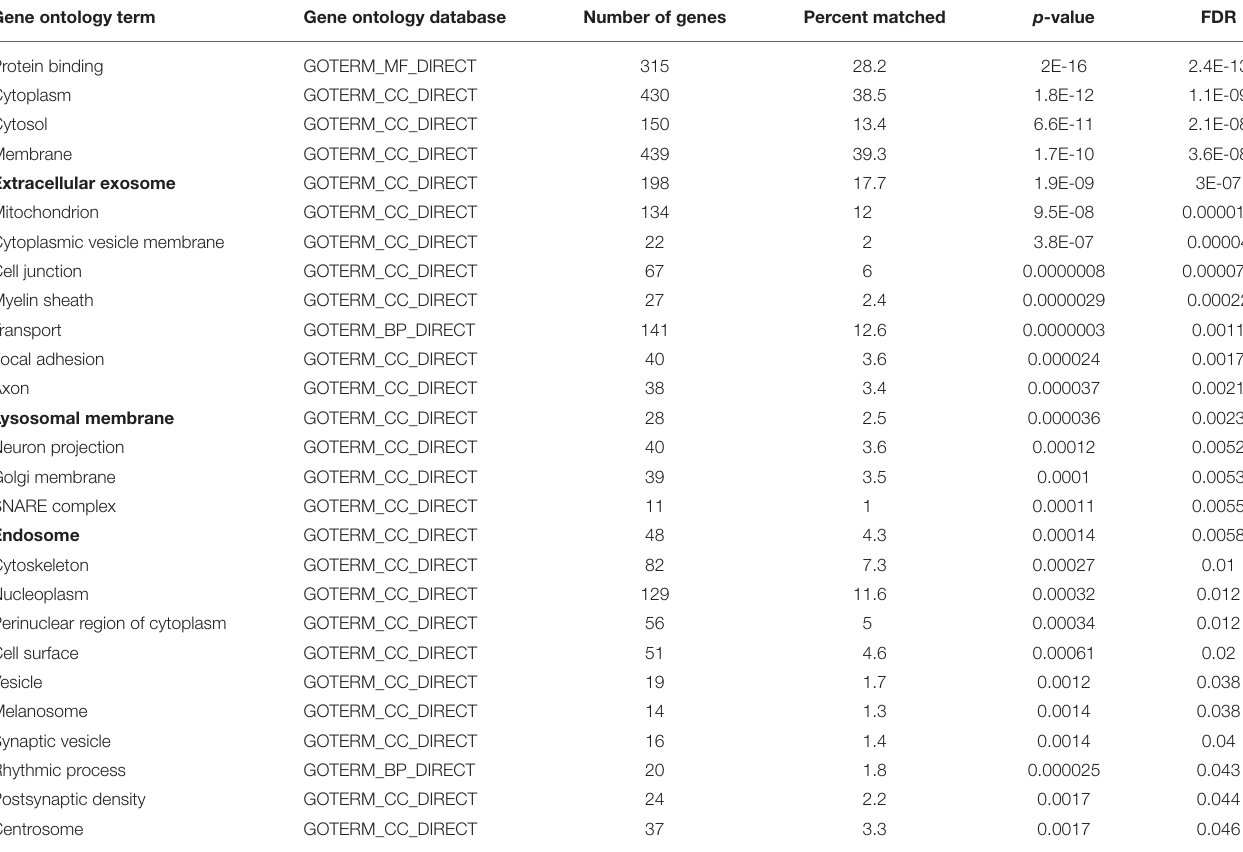
TABLE 2 | Enriched Gene Ontology Terms in the EC of APOE3/4 vs. APOE3/3 mice. Gene ontology term